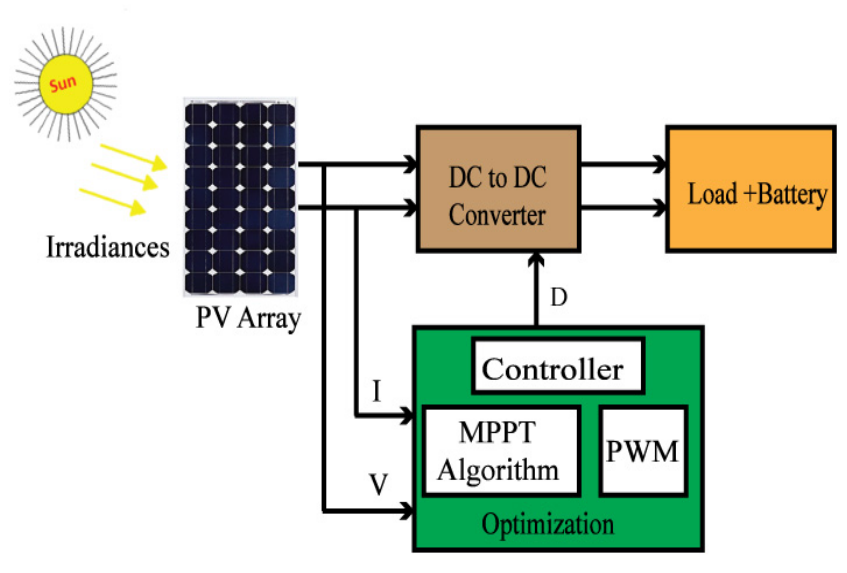
Figure 1. Centralized PV